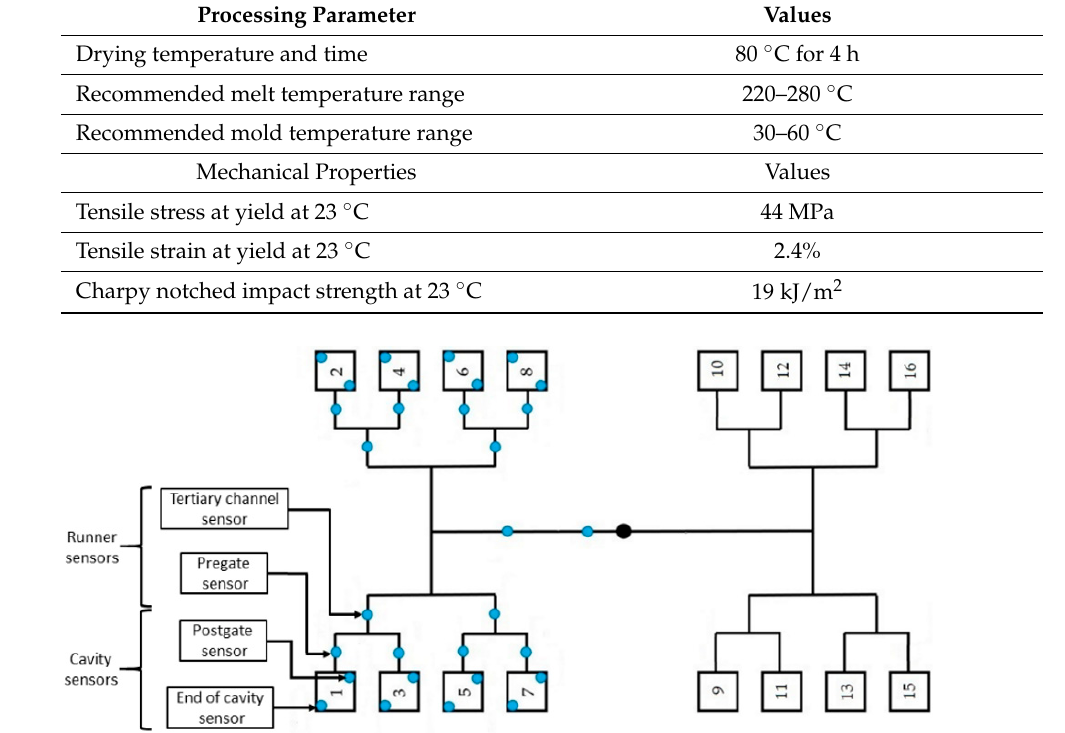
Figure 1. A multi-cavity mold and locations of pressure sensor locations. Table 2. Injection molding parameters—fixed parameter Table 1. Recommended processing parameters by the manufacturer (Terluran GP-35 ABS) and the mechanical properties of the material.